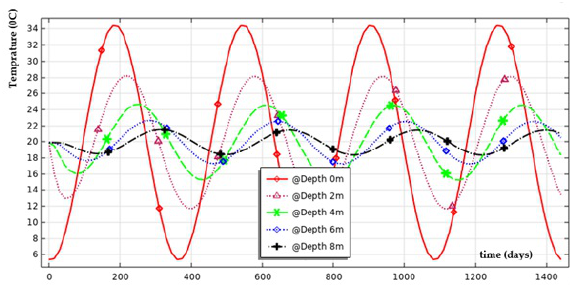
Fig. 6. Soil temperature at various depths in 4